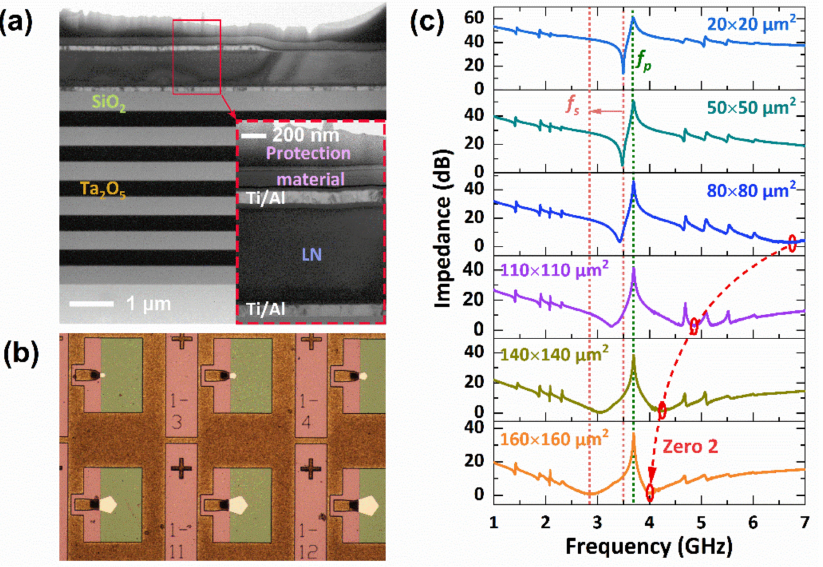
Figure 2. ( a ) Cross-section morphology of the resonator by a transmission electron microscope; ( b ) Electrode morphology of resonators; ( c ) Measured impedance curves with a resonant area from 20 × 20 µ m 2 to 160 × 160 µ m 2